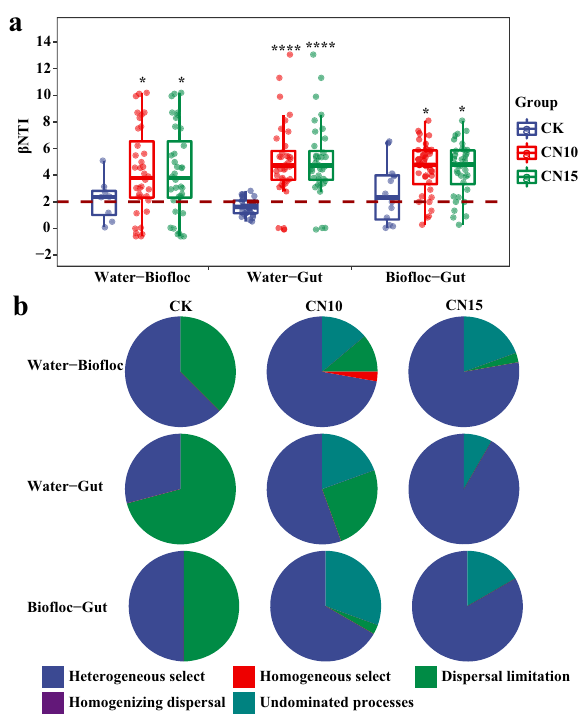
Fig. 6 The ecological processes of bacteria from water to bio fl oc, water to gut, and bio fl oc to gut in control and sucrose addition groups. a The β NTI values. The boxes represent the median and interquartile range, and whiskers range from minimum to maximum values. Different asterisks indicate a signi fi cant difference at * p < 0.05, and **** p < 0.0001 based on Student ’ s t test. b The contribu- tions of stochastic processes and deterministic process on the bacterial assembly. Each sample had six replicates ( n = 6), except the water samples ( n = 4) and bio fl oc samples ( n = 2) in control group. CK: without sucrose addition; CN10: the C/N ratio of about 10:1 obtained by sucrose addition; CN15: the C/N ratio of about 15:1 obtained by sucrose